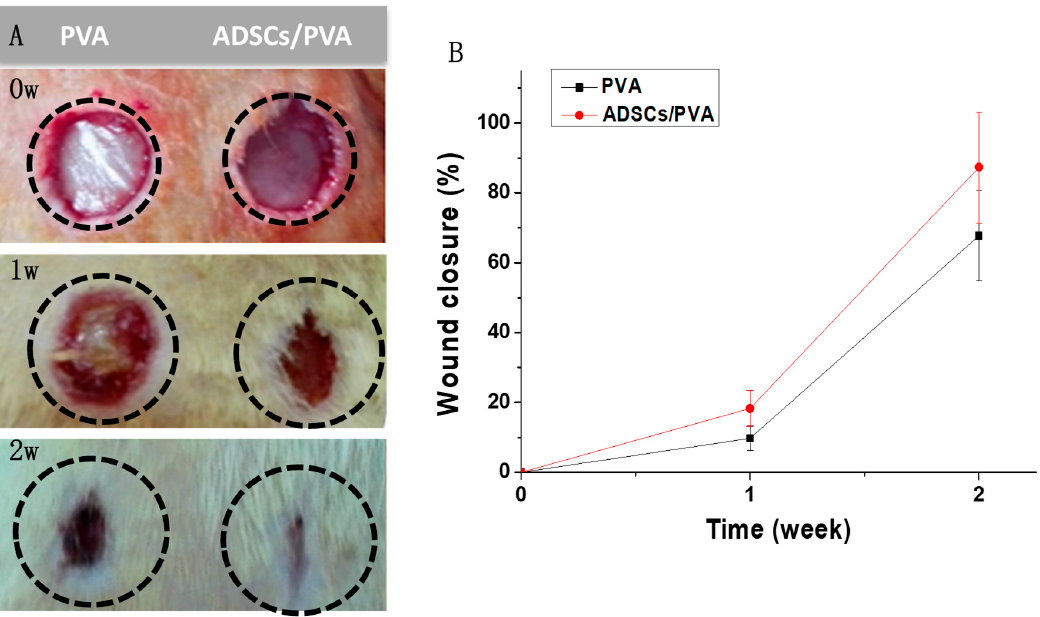
Figure 7. Photographs ( A ) and measurements ( B ) of wound healing of full thickness square defects in rats after different periods of time.